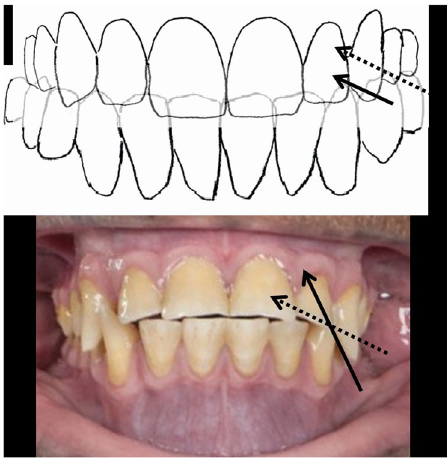
Fig. 7 The “ reduced canine ” -trait that distinguishes humans from other simians. Unlike humans (top), the paralleling cuspal inclines of the paracone/protoconid (dashed arrows) are not equal to the guiding incline (solid arrows) of the large and overlapping upper and lower canines of e.g. Pan